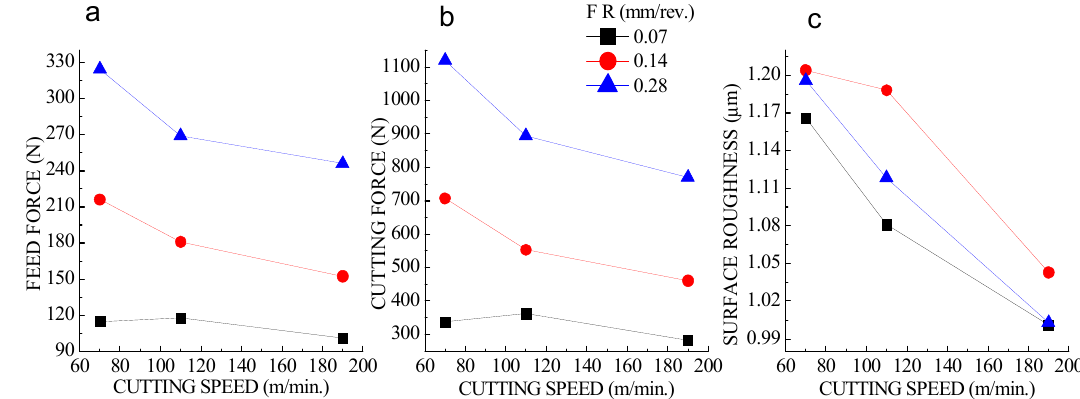
Figure 5. Graphs of ( a ) cutting speed vs. feed force; ( b ) cutting speed vs. cutting force; and ( c ) cutting speed vs. surface roughness at 0.9 mm depth of cut.